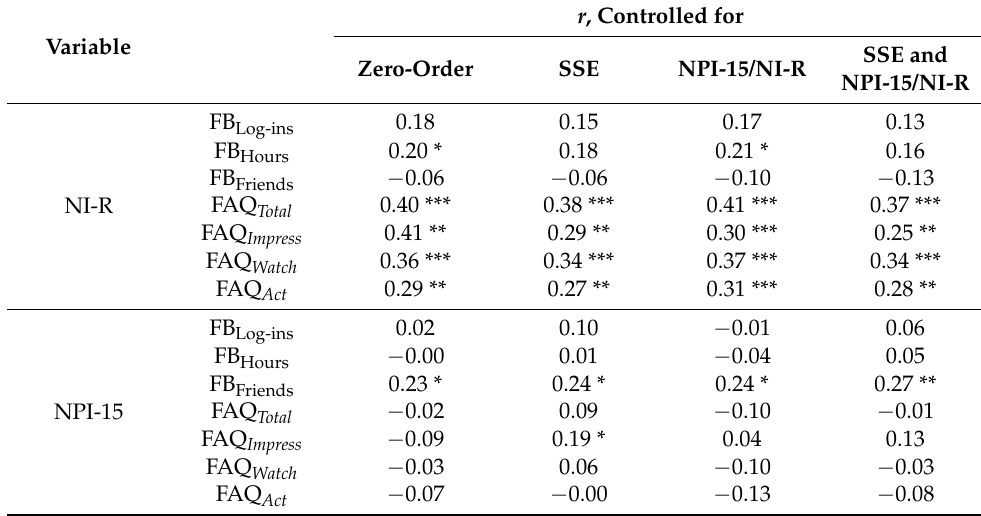
Table 4. Correlations of the two facets of narcissism with measures of Facebook activity.